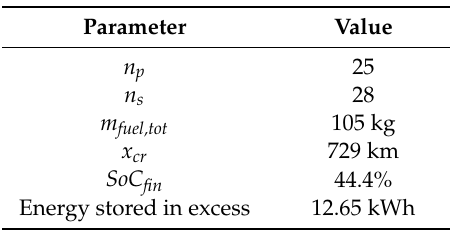
Figure 11. Variation of SoC and the current in the climb phase in optimization Problem 2. Table 5. Final values of Problem Table 6. Problem 2 for different cells and DC-link voltages.